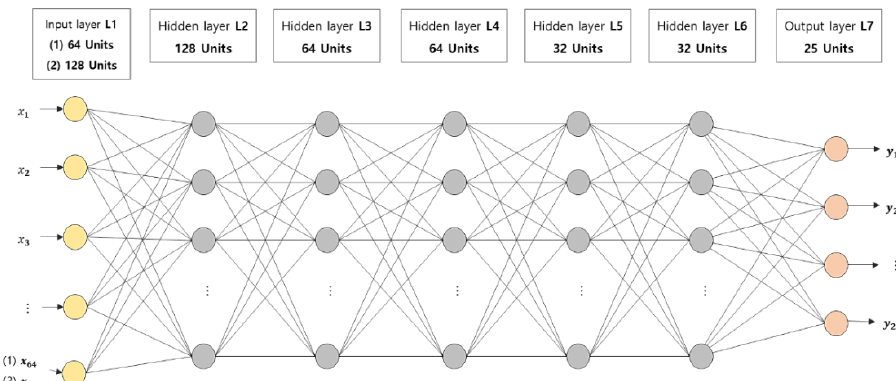
Figure 7. Proposed deep neural network (DNN) model.